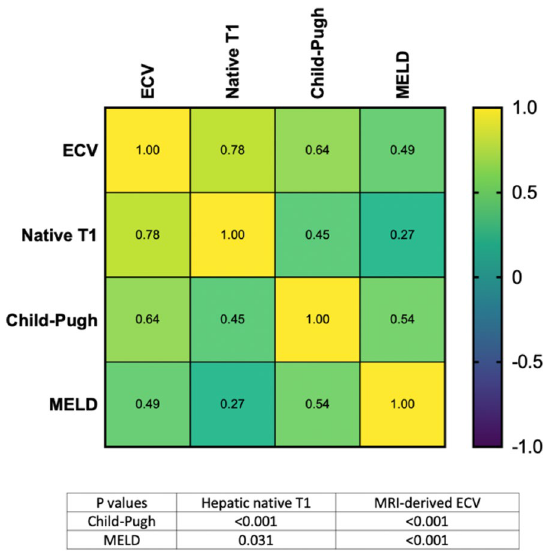
Figure 3. Heatmap shows correlations between hepatic native T1 and MRI-derived extracellular volume fraction (ECV) and clinical scores of liver disease severity. ECV extracellular volume fraction, MELD model for end-stage liver